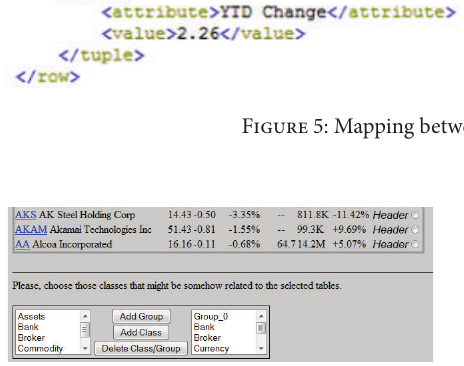
Figure 6: Screenshot of the selection of the relevant ontology